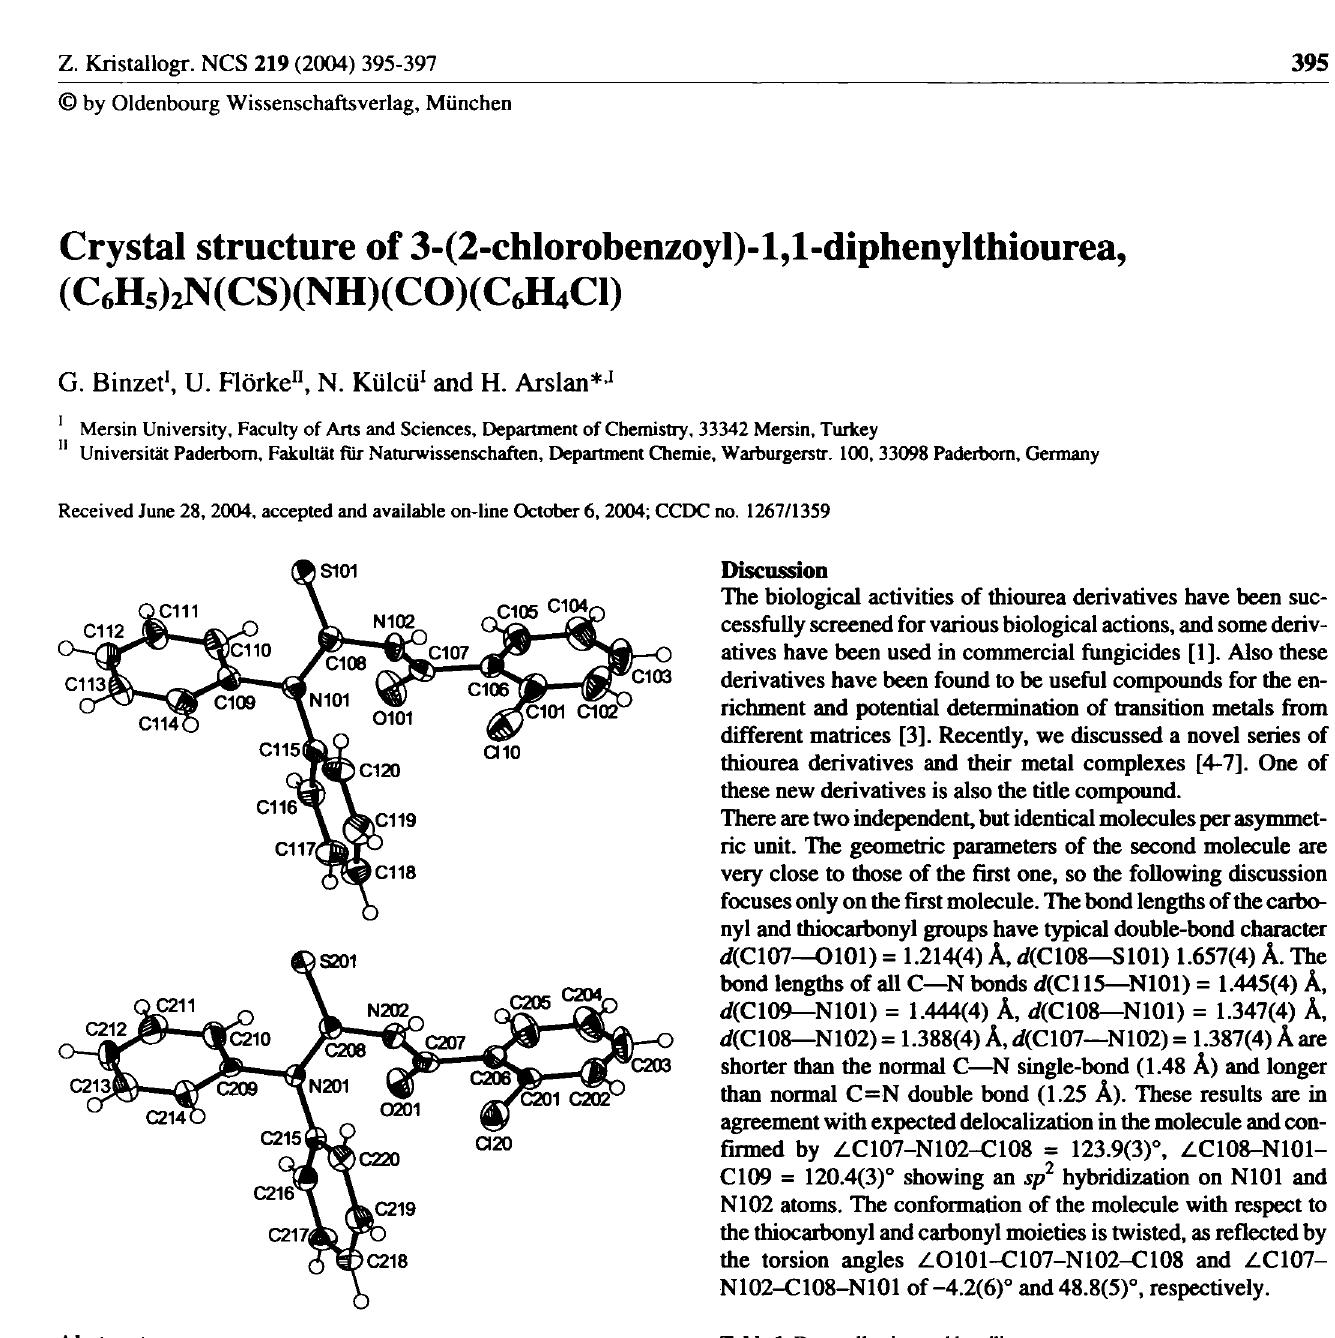
Table 1. Data collection and handling.